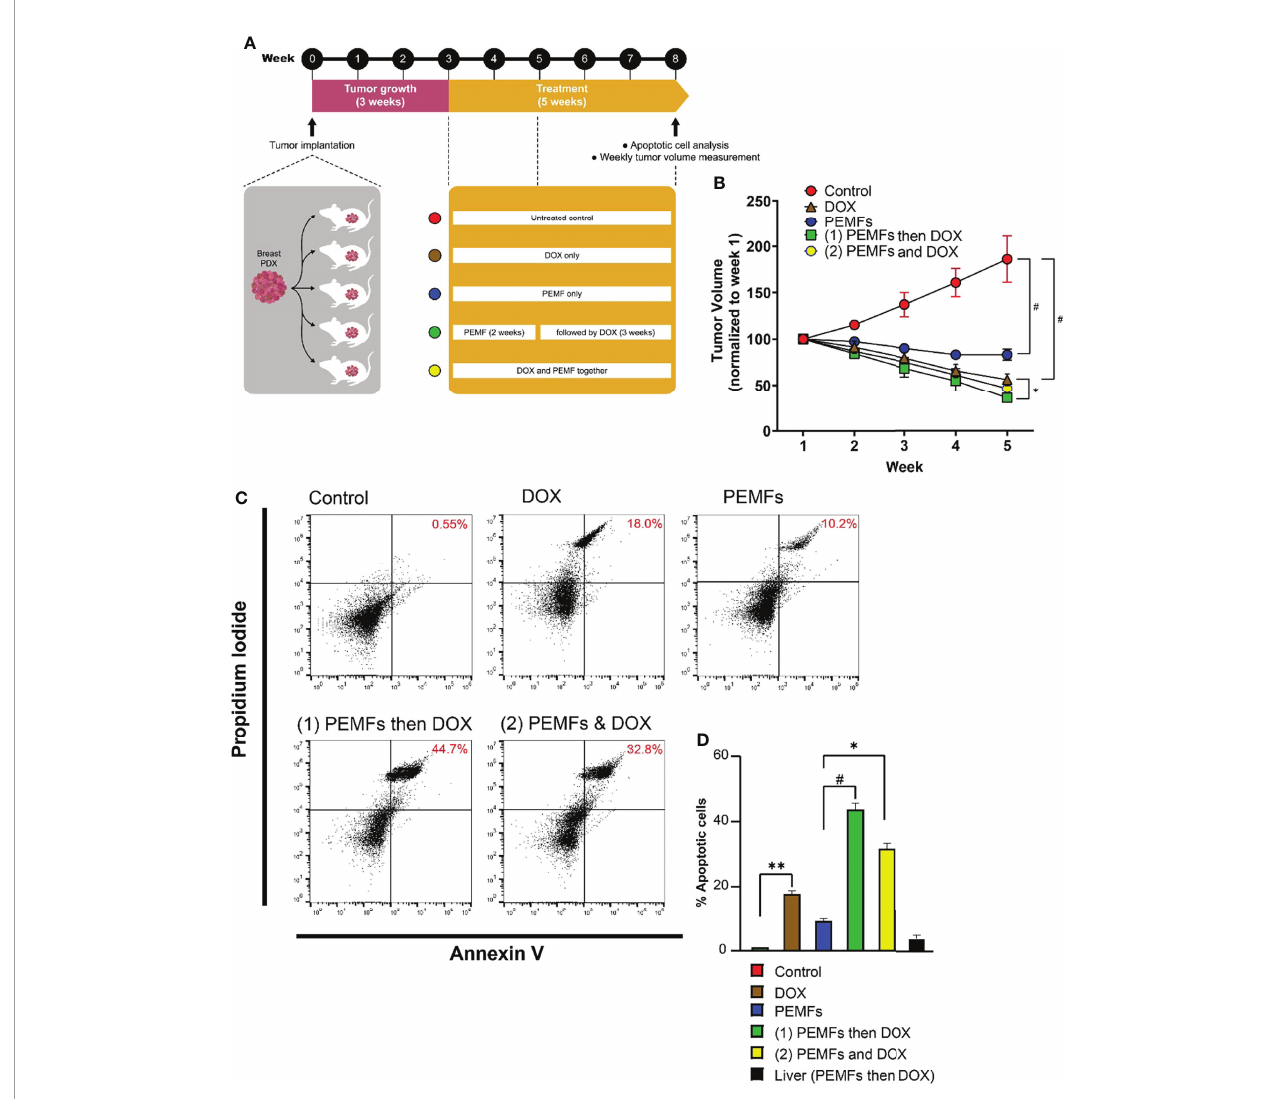
FIGURE 1 | PEMFs synergize with DOX to inhibit tumor growth in vivo . (A) Schematic of PEMF and DOX exposure regimes used on mice hosting patient-derived tumor xenografts. Implanted tumors were allowed to grow for 3 weeks before the initiation of DOX (20 mg/kg) and/or PEMF treatments. Tumor volumes were measured each week while apoptotic cell determination was performed at the end of the study. Each data point represents the mean values from 5 experimental runs derived from the tumors obtained from 5 patients, each of which was equally divided amongst the 5 treatment groups. (B) Changes in tumor volume (mm 3 ) for 5 weeks. (C) Representative scatter dot-plots showing cell populations from dissociated tumors based on Annexin V and propidium iodide staining. (D) Quanti fi cation of apoptotic cell percentages obtained using fl ow cytometry. *p < 0.05, **p < 0.01, and # p < 0.0001. Error bars represent the standard error of the